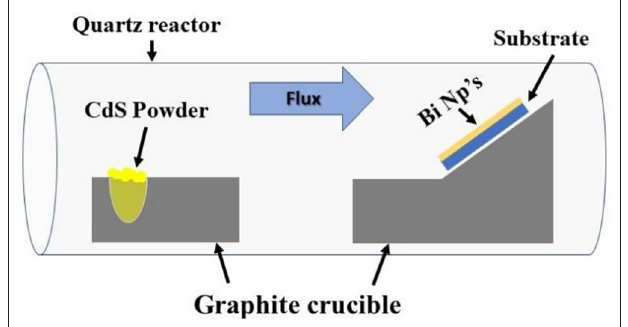
FIGURE 2 | Experimental setup used to grow CdS Nws. The source and substrate are located in two graphite crucibles inside a quartz reactor. were obtained, and their origin is discussed in relation with the growth